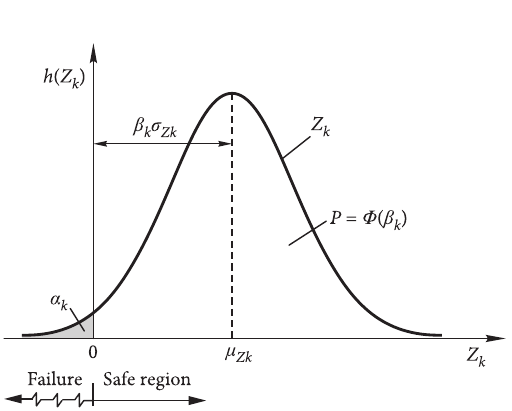
Fig. 2. The probability density function of the safety margin Z